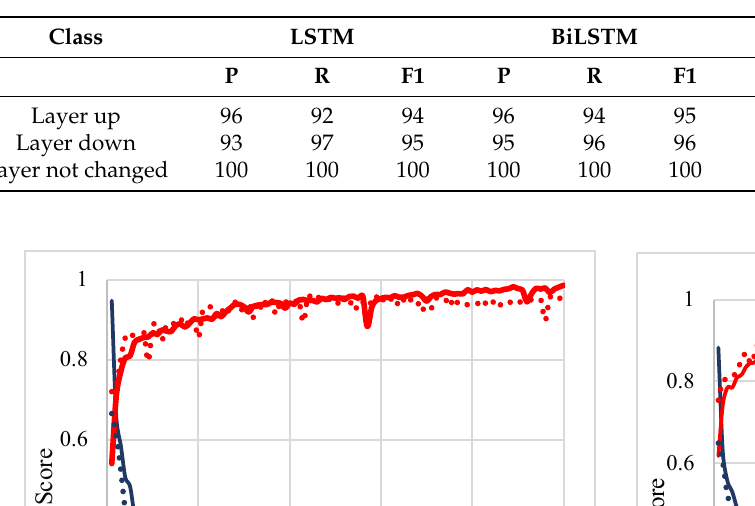
Table 3. Precision, Recall and F1 score.